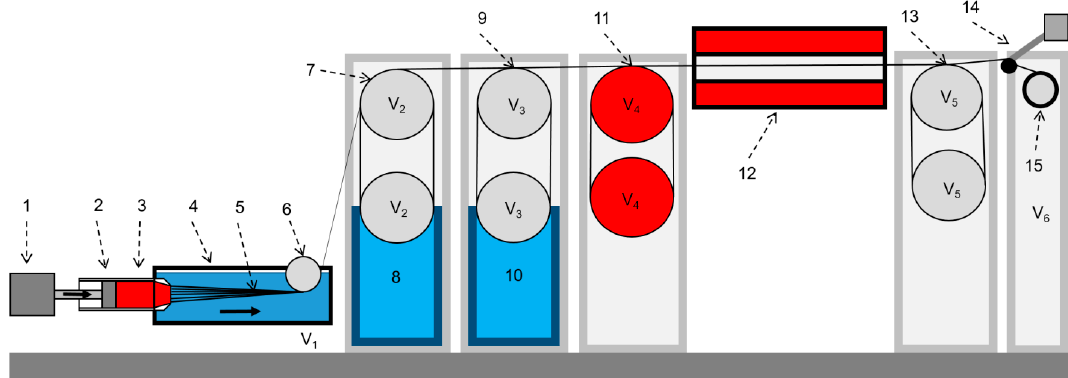
Figure 14. A scheme of the wet spinning stand. 1 —solution supply device; 2 —a syringe; 3 —dope; 4 —coagulant; 5 —complex yarn; 6 —take-up roller (spinbond hood); 7 , 9 —flushing rollers; 8 , 10 —washing bath; 11 —drying drums; 12 —zone of thermal extension; 13 —supporting rollers; 14 —yarn spreader; 15 —winding roller.